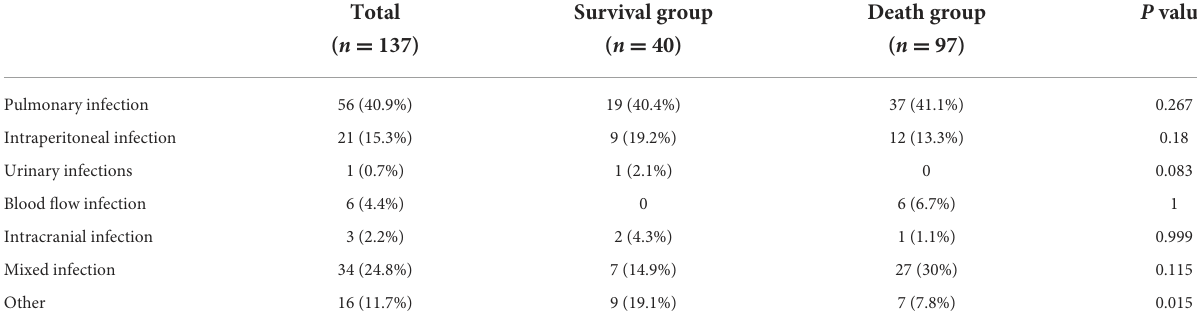
TABLE 3 Distribution of type septic shock infection by